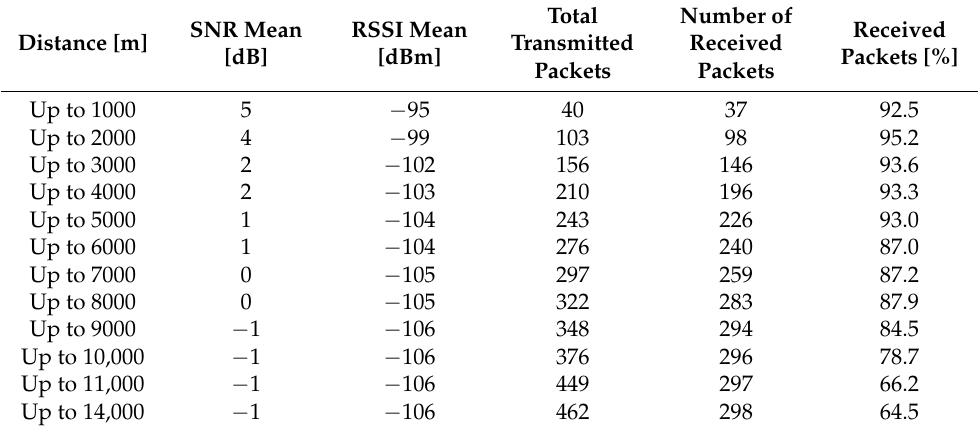
Table 3. Results of the point-to-point measurements in open environment (Setup